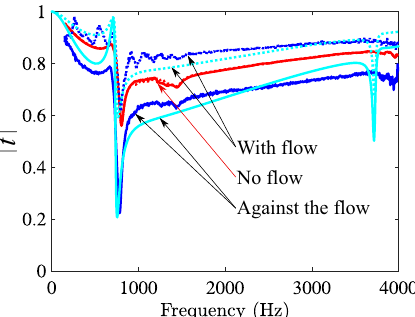
Figure 12. Transmission coef fi cients of the lined sample in presence of fl ow ( M = 0.25). The experimental results (red curves without fl ow, blue curves with fl ow) are compared to the multimodal calculation (only the results with fl ow are shown, cyan